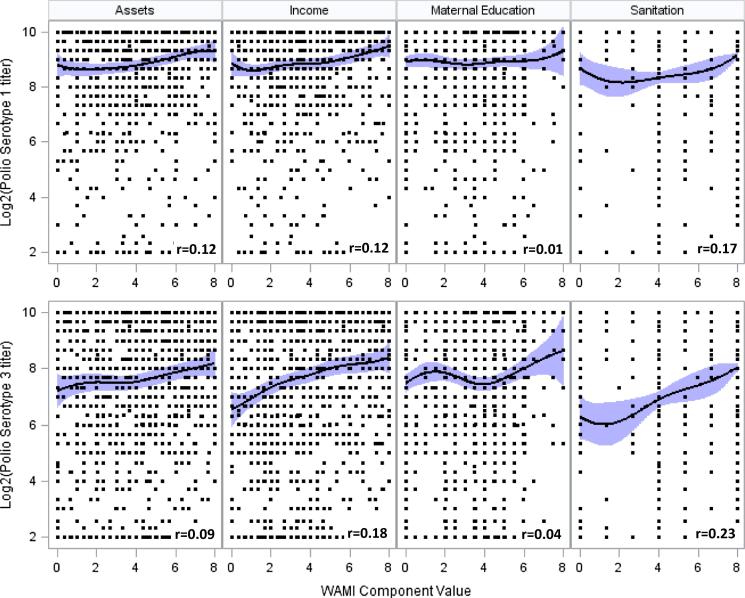
Serotype 1 and 3 titer distributions and confidence intervals for WAMI component scores at 15 months. Penalized B-splines were fit using 10 knots. Pearson correlation coefficients (denoted r) are reported in the lower right corner of each scatter plot (all correlations have p < 0.0001 for the test of r being different from 0, except correlations with Maternal Education, which were not significant)